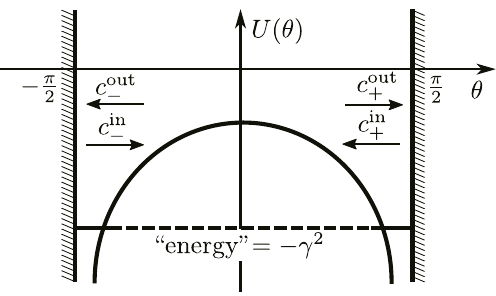
Figure 3 . Propagation of physical states in asymptotic regions of g AdS 2 . We show coe(cid:14)cients de(cid:12)ned in (4.10) corresponding to amplitudes of ingoing and outgoing